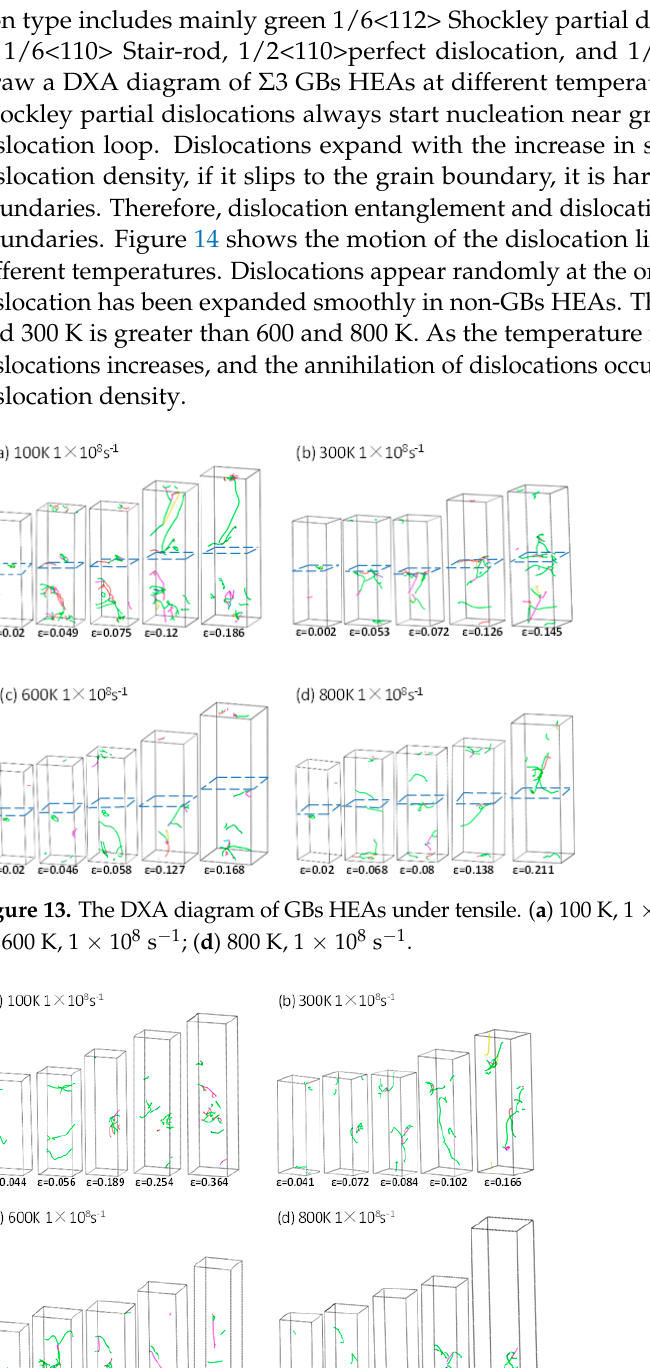
Figure 12. The CNA diagram of non-GBs HEAs under tensile. ( a ) 100 K, 1 × 10 8 s − 1 ; ( b ) 300 K, 1 × 10 8 s − 1 ; ( c ) 600 K, 1 × 10 8 s − 1 ; ( d ) 800 K, 1 × 10 8 s − 1 .